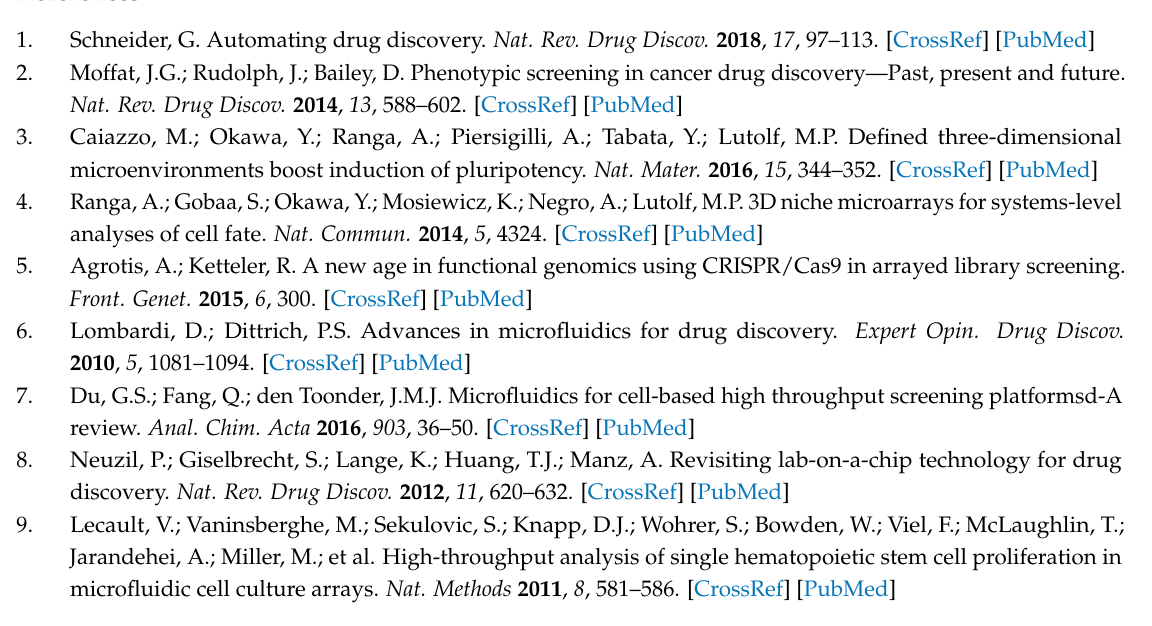
Figure S1: Photo of stock blocks wrapped with Parafilm M for storage and without film; Figure S2: Plugs of Rhodamine B dye loaded in reagent holes of the stock block before and after centrifugation; and Figure S3: Calibration curve between the calcein concentrations and fluorescence intensities in the reagent and cell chip assembly; Video S1: The operation of